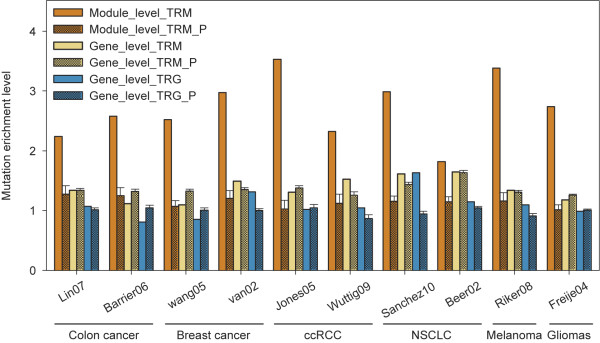
Mutation enriched in TRM at module level. The mutation enrichment level for TRM (Module_level_TRM) is calculated as the ratio of the number of MM in TRMs_100 and remaining modules. As a control we also performed the same analysis on the mutated genes in TRMs_100 (Gene_level_TRM), top rank t-test genes with the same number of genes in TRMs_100 (Gene_level_TRG), and their respective permutation test controls.